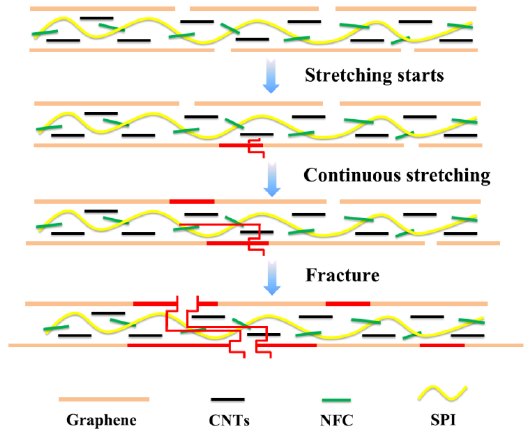
Figure 7. Proposed crack extension model of SPI/G/CNT/NFC nanocomposites.